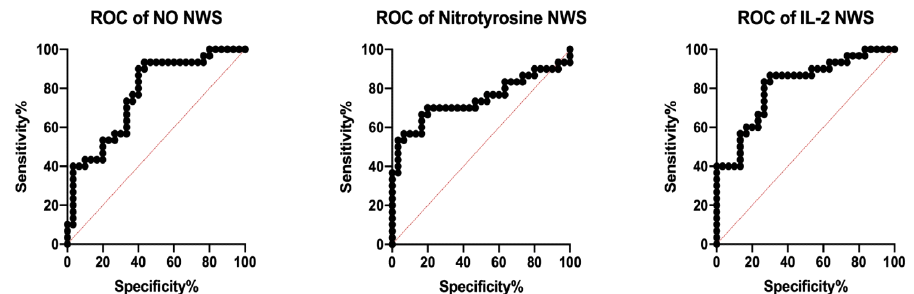
Figure 4. Receiver operating characteristic (ROC) analysis of nitric oxide, nitrotyrosine, and IL-2 in unstimulated saliva of plaque psoriasis patients with normal salivation and hyposalivation. IL-2—interleukin 2; NO—nitric oxide; NWS—non-stimulated whole saliva.